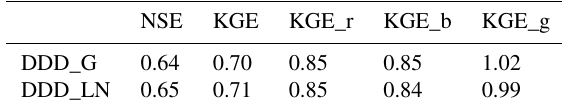
Table 2. Mean values of skill scores for the validation period 2000– 2014 simulated with DDD_G and DDD_LN for 71 catchments. KGE_r measures correlation, KGE_b, the bias error and KGE_g the variability error. All skill scores have an ideal value of